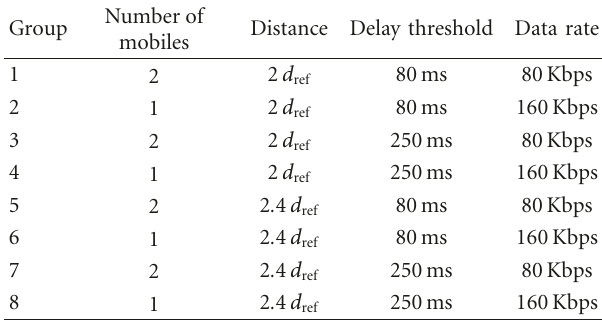
Table 4: Fourth scenario